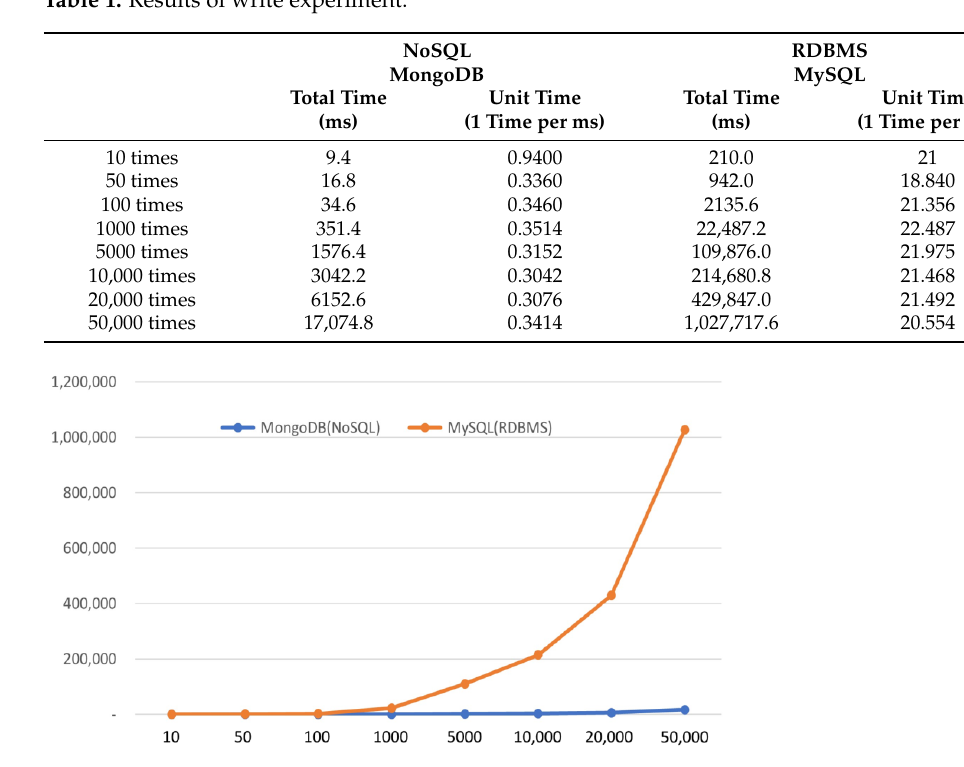
Figure 11. Results of write performance experiment ( x -axis: number of data points, y -axis: write speed in ms).